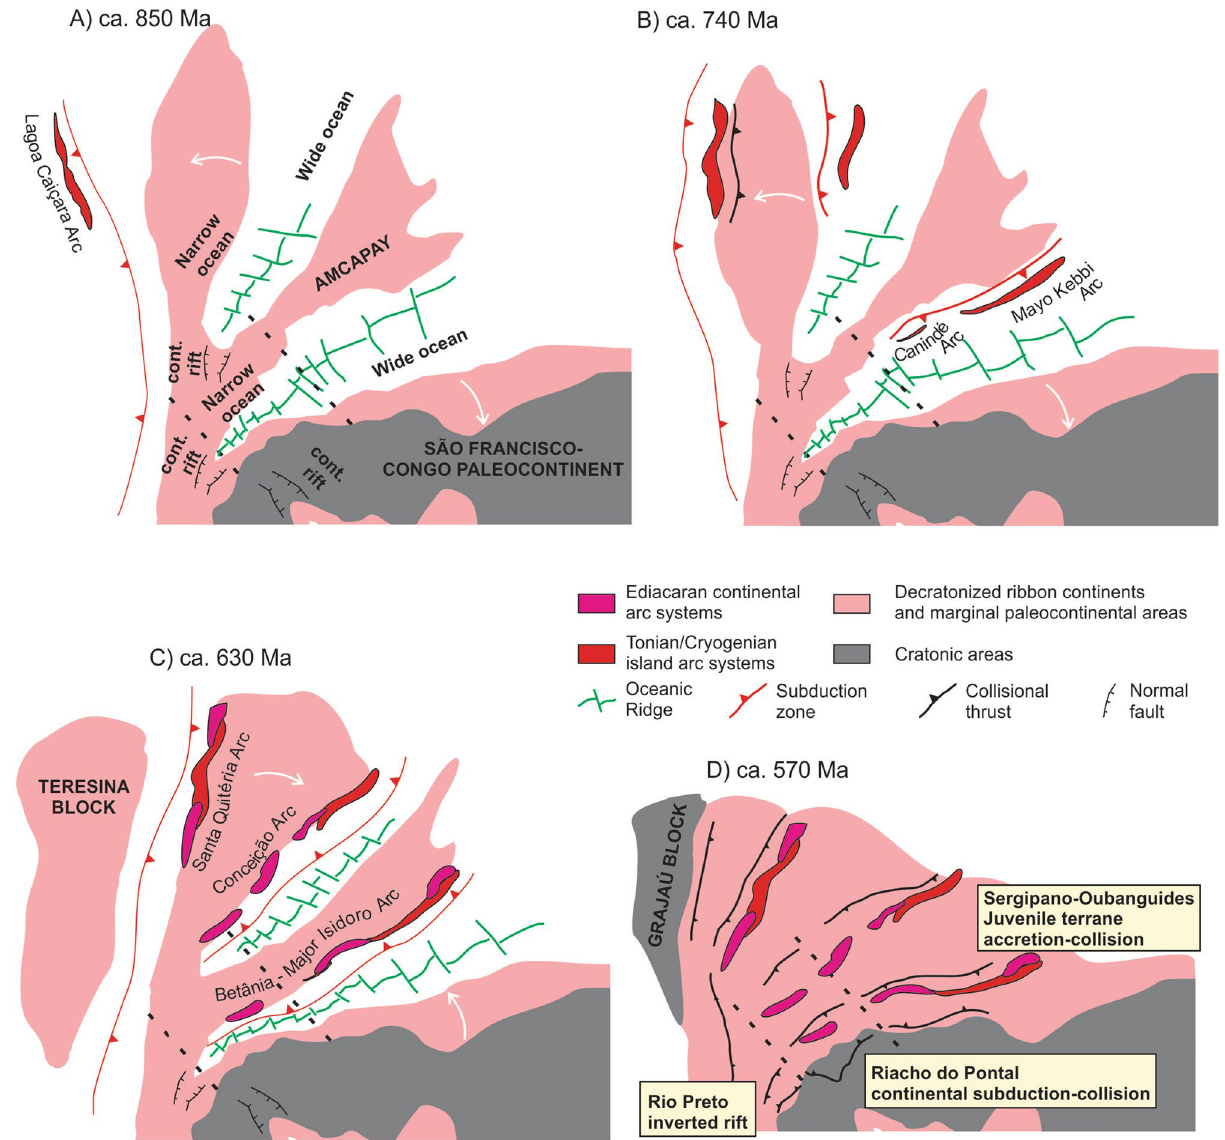
Figure 5. Schematic evolution of the V-shaped Transnordestino-Central African ocean in the northern São Francisco-Congo paleocontinental margin. Drawing created using Corel Draw Graphics Suite 2018 (http:// www. corel draw. com) and a Huion Kamvas GS1331B pen display (http:// www. huion.